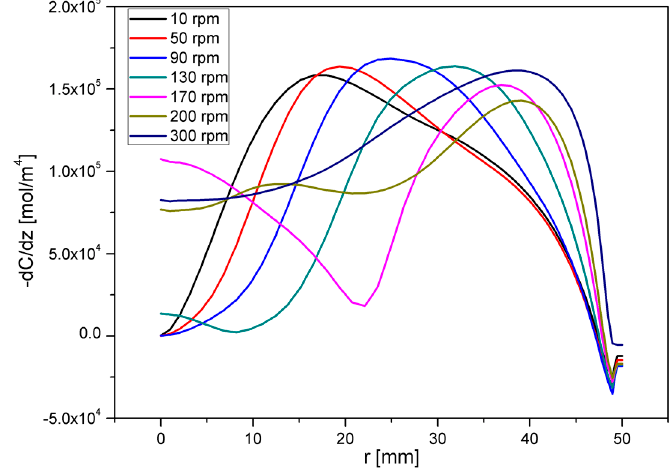
Figure 5. Variation in the concentration gradient along the seed radius.